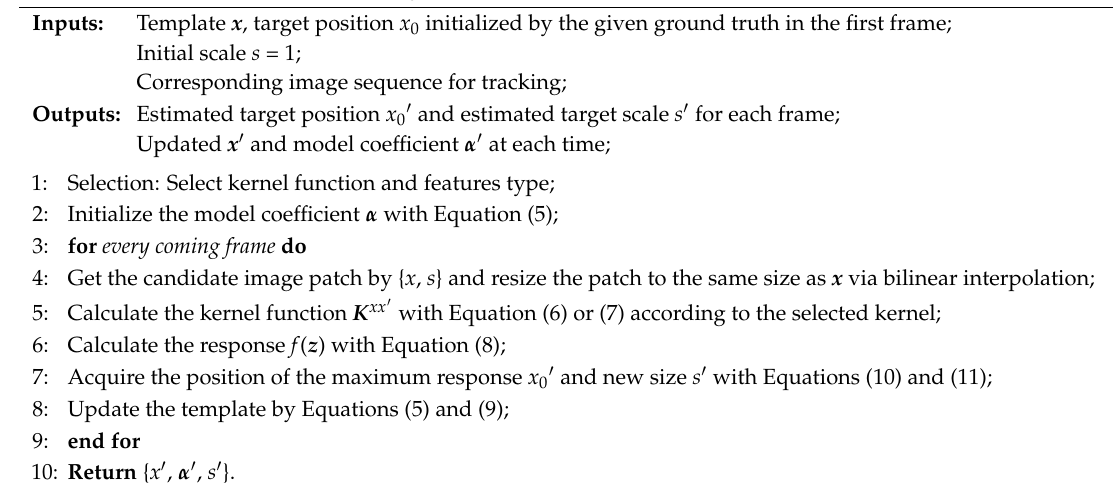
Algorithm 1. The KCF tracker with target scale